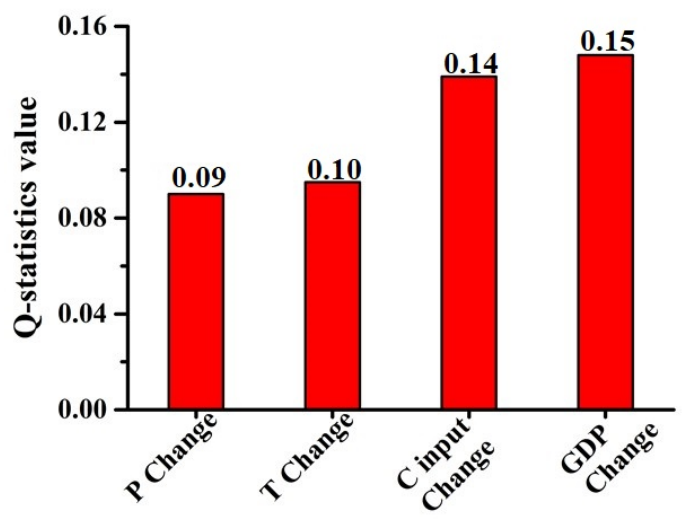
Figure 7. The impact of anthropogenic activities on the changes in soil organic carbon (SOC) in Aohan Banner.